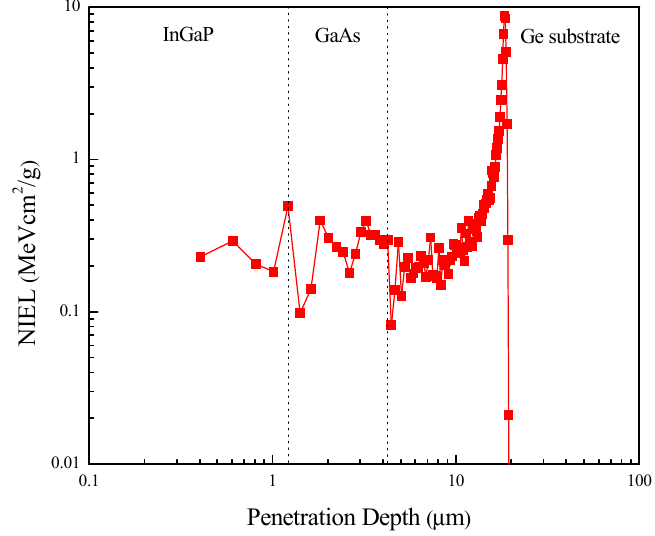
Figure 1. Non-ionizing energy loss (NIEL) as a function of 5.1 MeV alpha-particle penetration depth in the InGaP/GaAs/Ge solar cells.